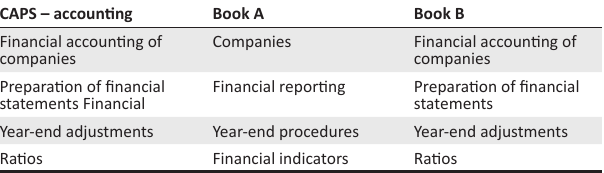
TABLE 3: Comparison of terminology used in textbooks.